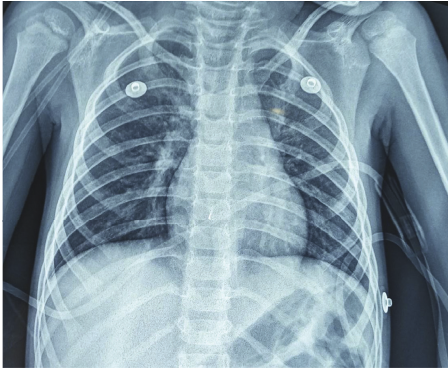
Figure 1: Chest X-ray showing an alveolar-interstitial